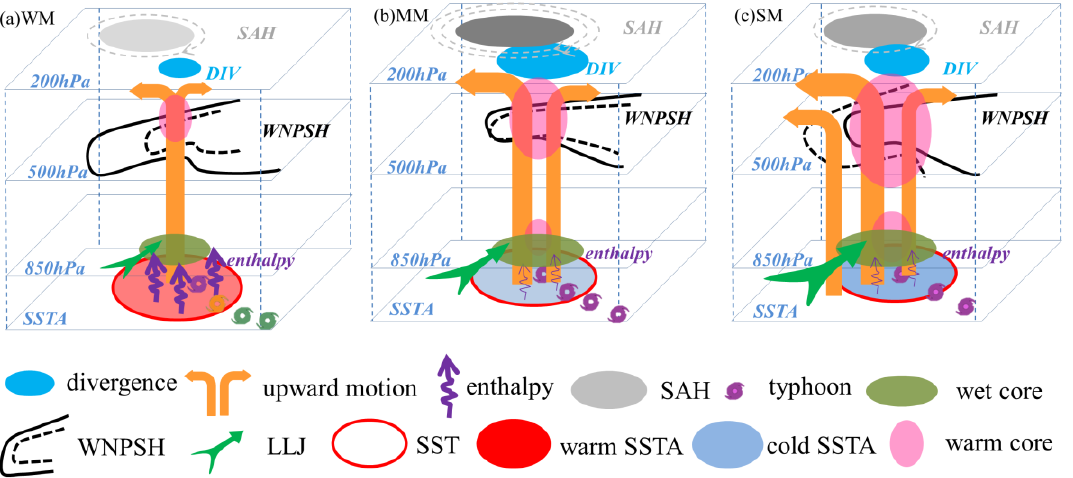
Figure 12. Schematic of the related element for three types of LSTYs in SC from surface to 200 hPa. ( a ) Cluster WM, ( b ) cluster MM, ( c ) cluster SM. Black solid and dash lines indicate the WNPSH at landfall time and 24 h before landfall, respectively.